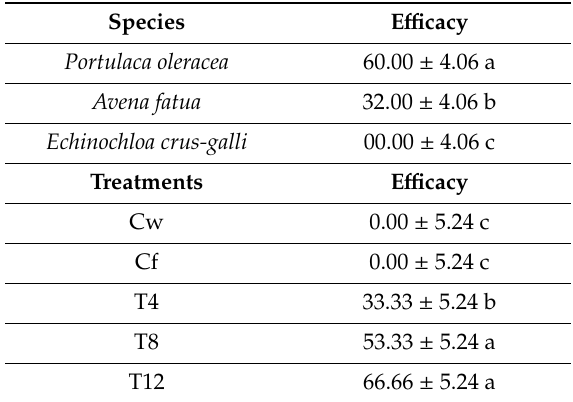
Table 7. TC4 e ffi cacy per species and per treatment. T4, T8, T12: 4, 8, 12 µ L / mL EO; Cw: water control; Cf: Fitoil control.